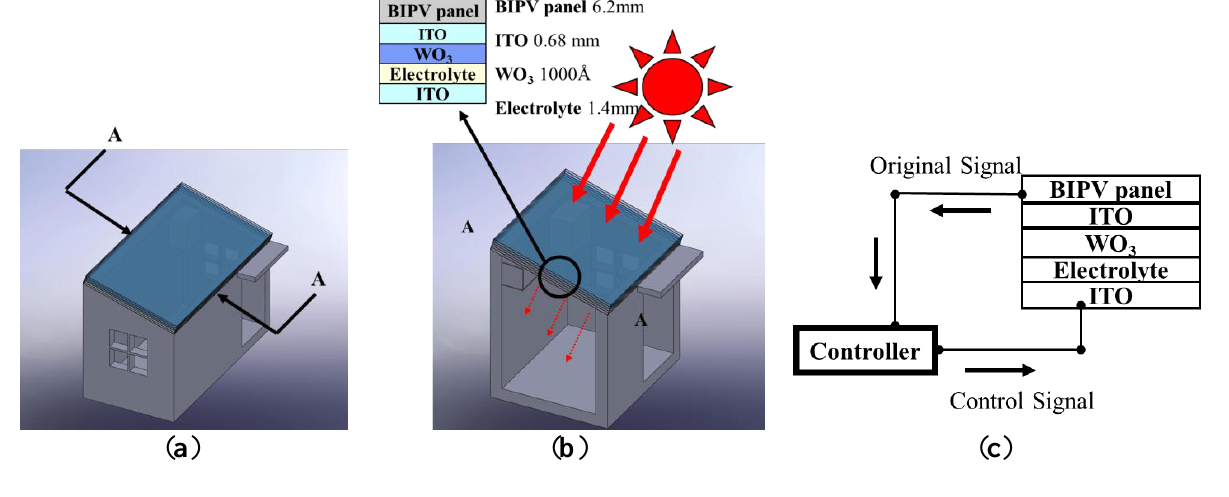
Figure 1. Schematic illustrations of smart window consisting of BIPV panel and electrochromic (EC) stack: ( a ) installation on roof of building; ( b ) cross-section A-A; and ( c ) signal path from BIPV module to EC stack via